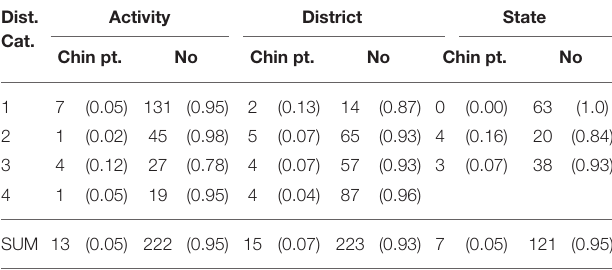
TABLE 6 | Raw frequencies (with proportions in parentheses) of chin points at the activity, district, and state scales. Dist. Cat.